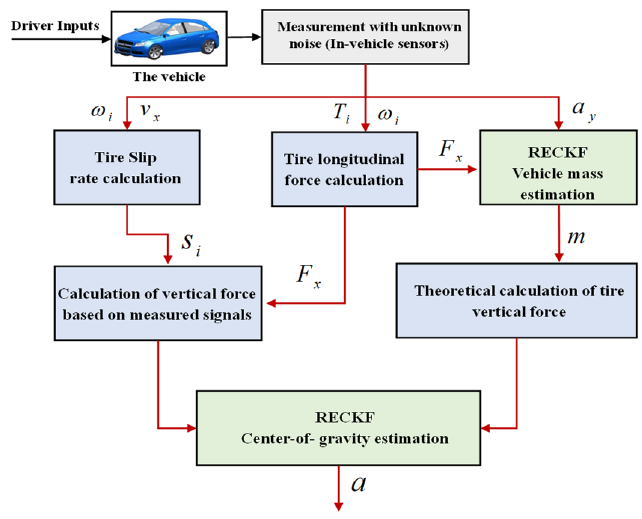
Figure 2. The framework of the estimation method.